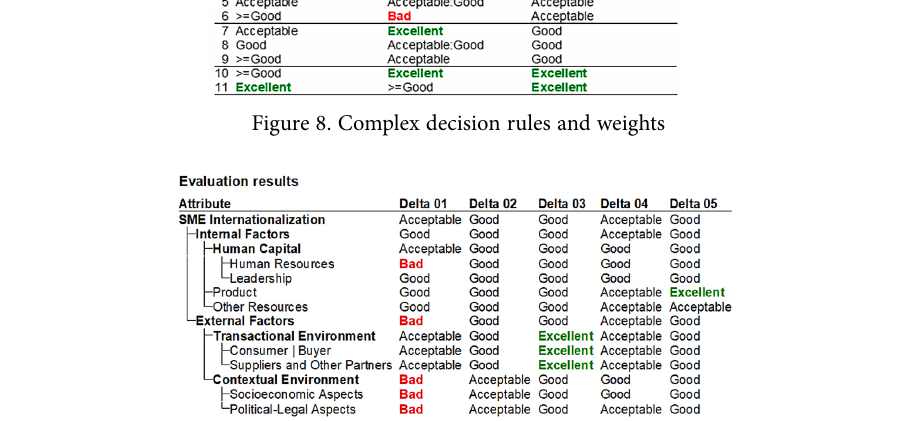
Figure 9. Deltas’ evaluation (overall and each